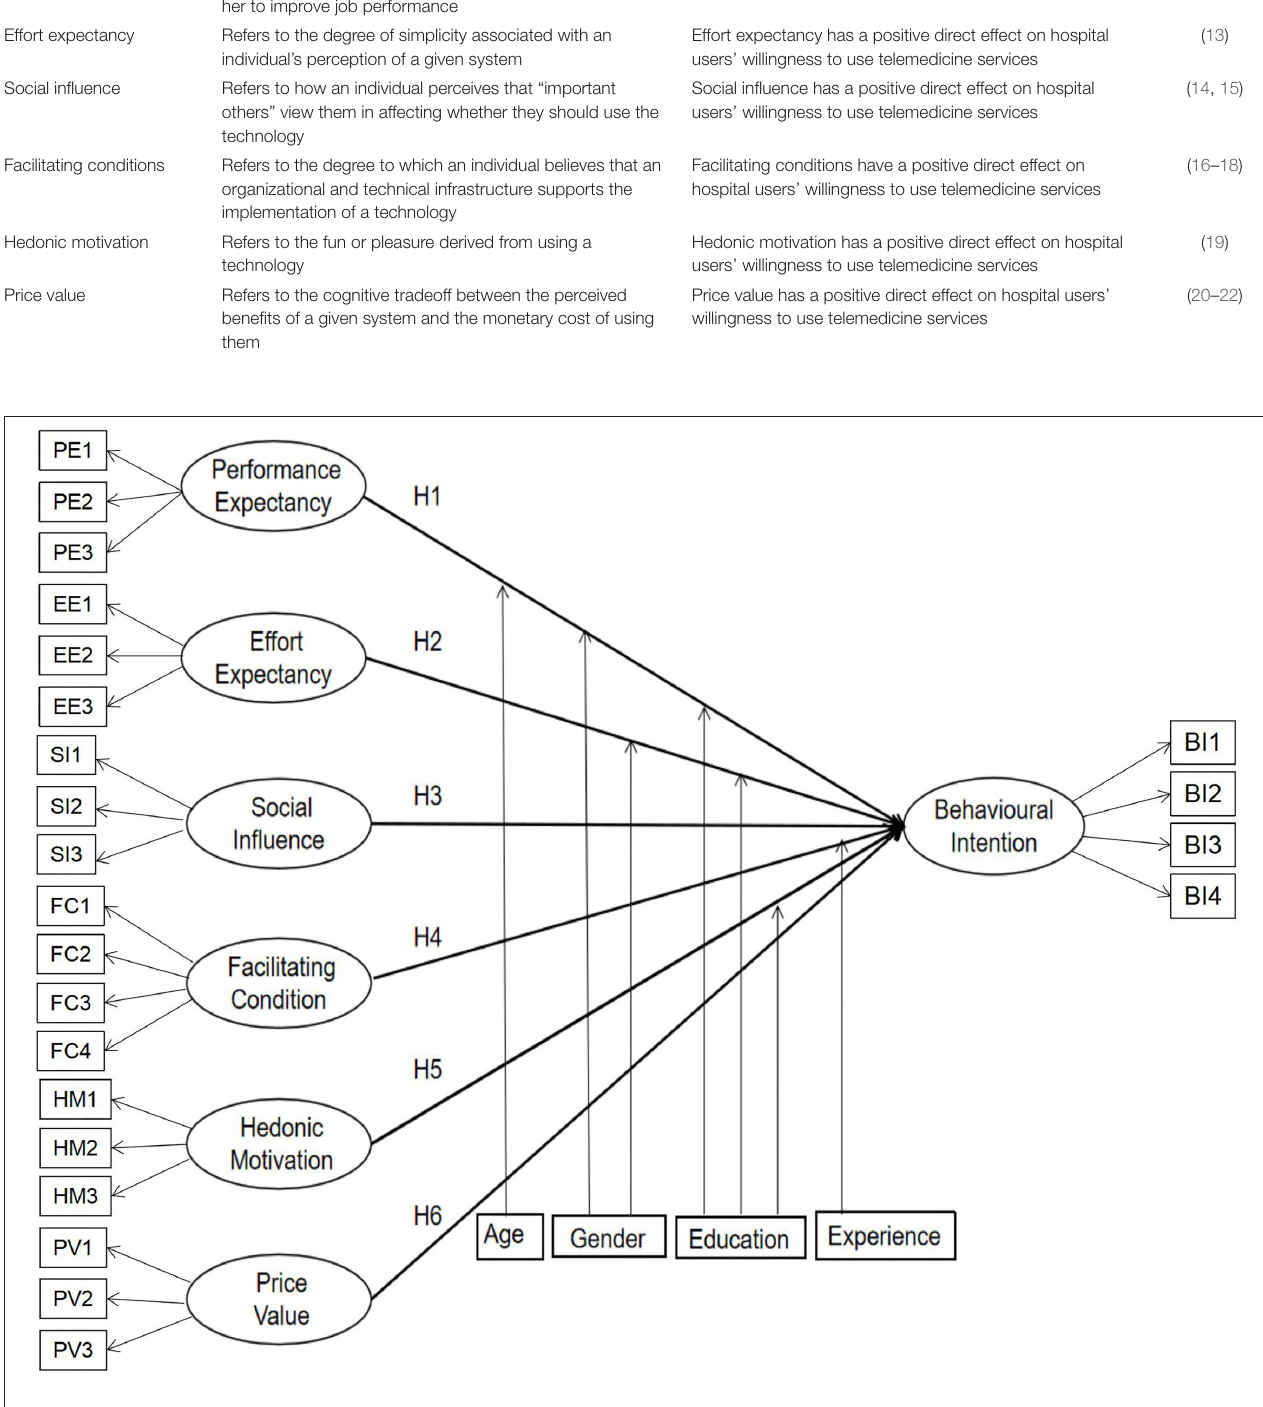
FIGURE 1 | Research